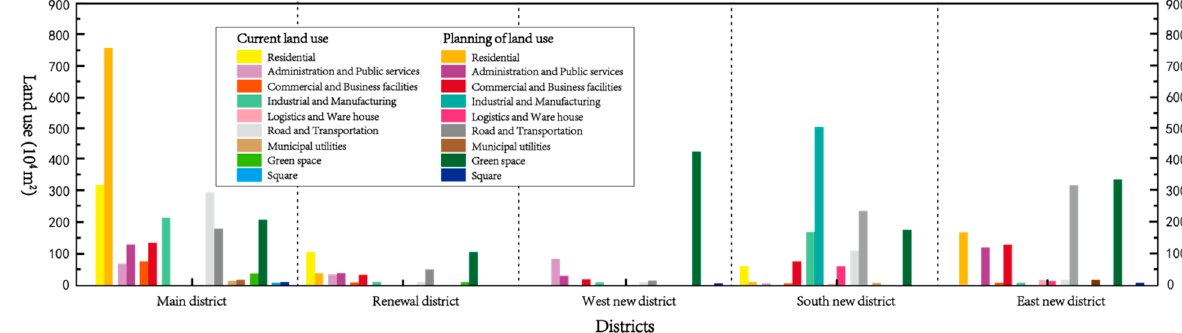
Figure 7. Land use and changes between current situation and the updated master plan.